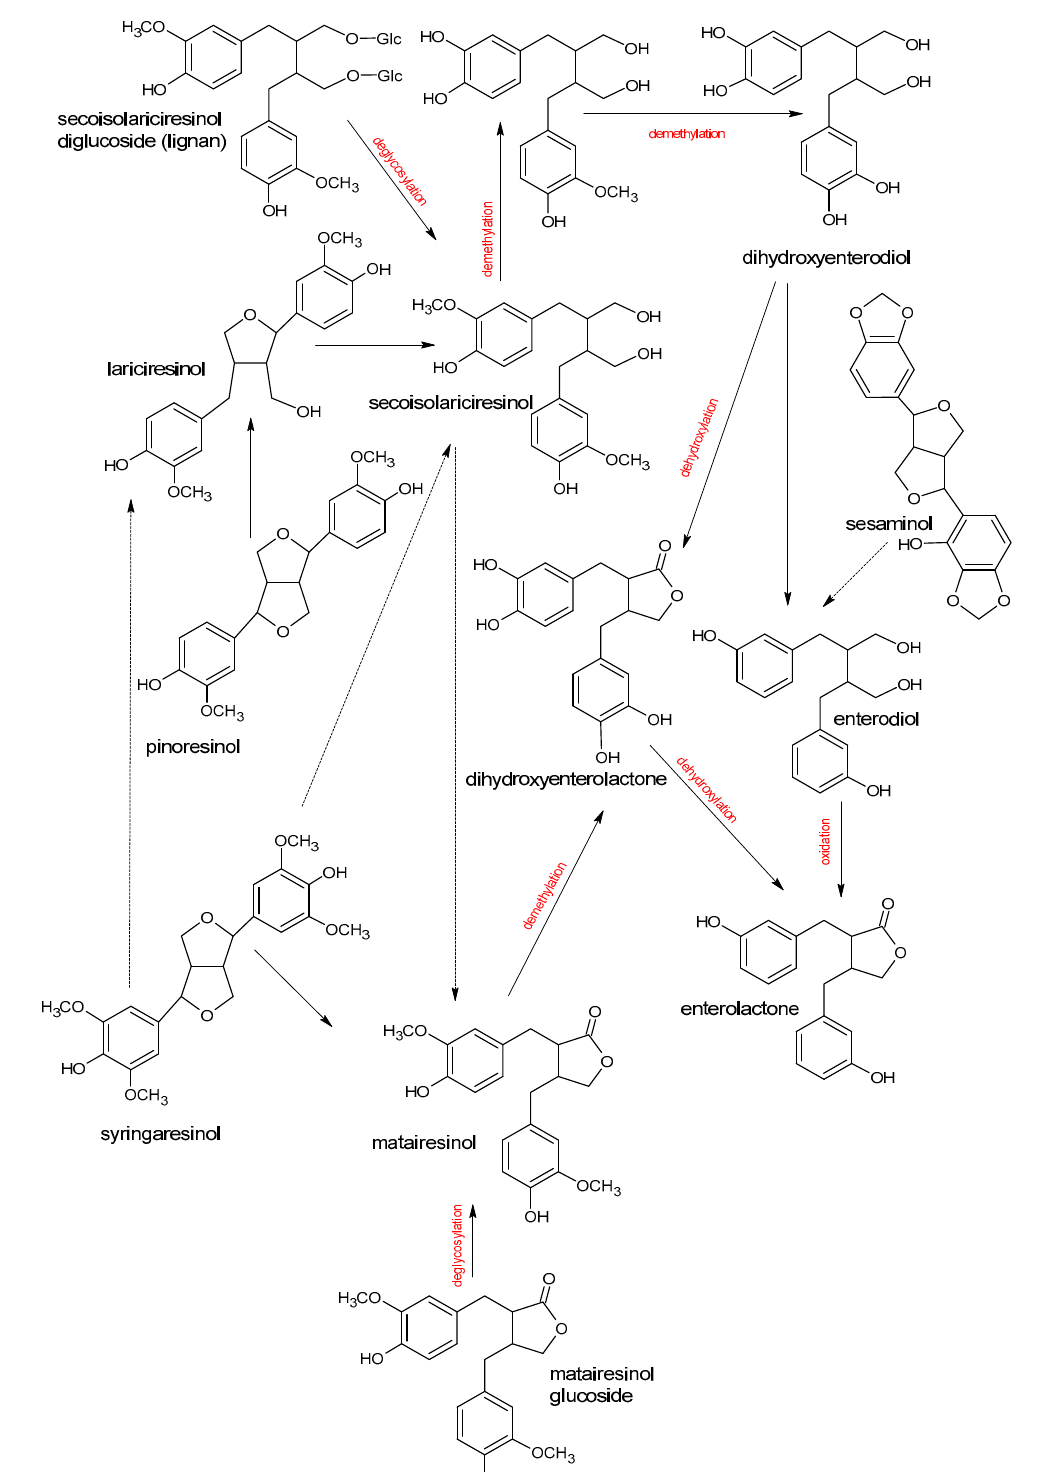
Figure 8. Lignans metabolism by gut microbiota. Based on [12,237,258–261]. The dashed arrows indicate hypothesized or multistep process.